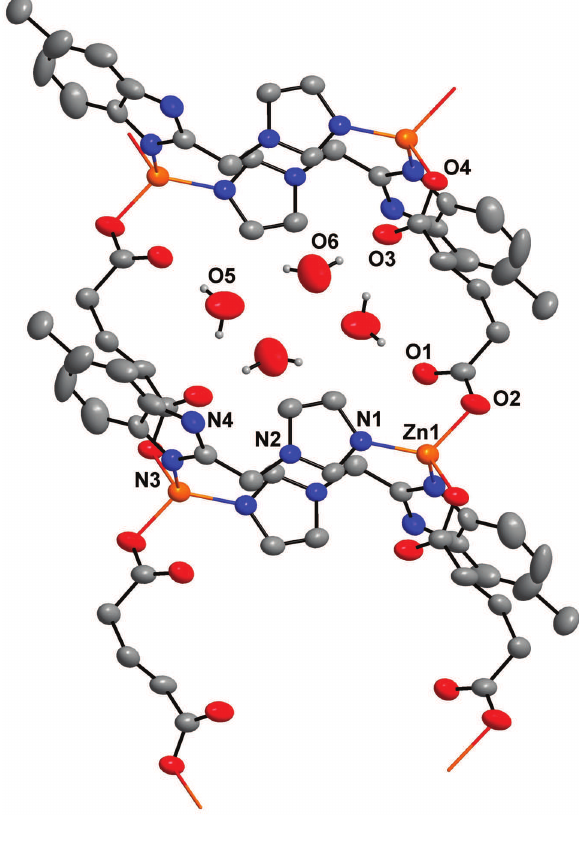
Table 1: Data collection and handling.